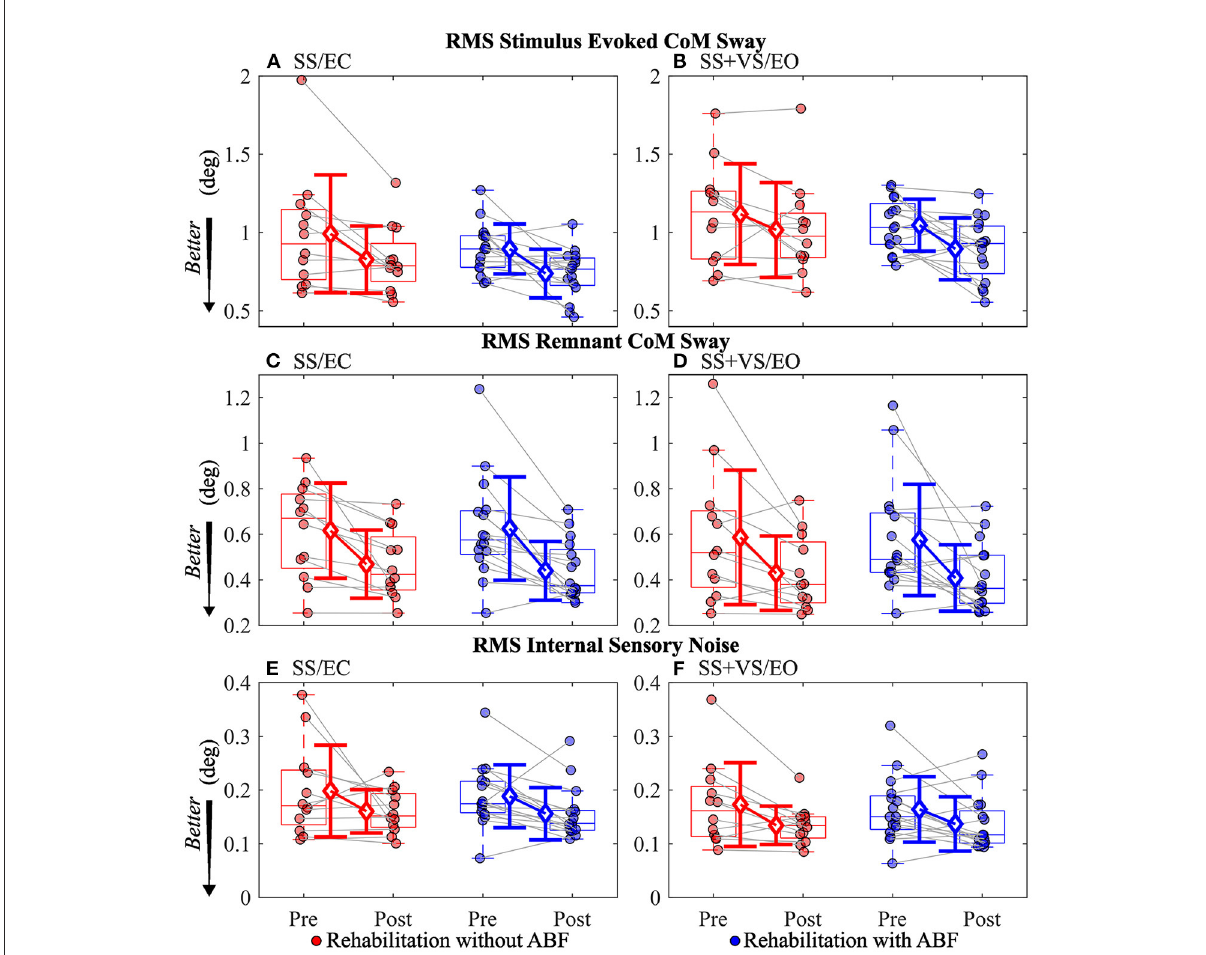
FIGURE4 Individual participant data pre- and post-rehabilitation for groups without audio biofeedback (ABF—red) and with ABF (blue) for Root Mean Squared (RMS) stimulus evoked Center of Mass (CoM) sway during (A) surface-tilt with eyes closed (SS/EC) and (B) during combined surface-tilt and visual-tilt with eyes open (SS + VS/EO); RMS remnant CoM sway during (C) SS/EC and (D) SS + VS/EO; RMS internal sensory noise during (E) SS/EC and (F) SS + VS/EO. Central box shows median (center line) with upper and lower quartiles defined by 0.75 quantile and 0.25 quantile values, respectively. Whiskers extend to maximum and minimum values that are not considered outliers. Mean group values are indicated by open diamonds with + /- 1 standard deviations. Gray lines connect individual participant